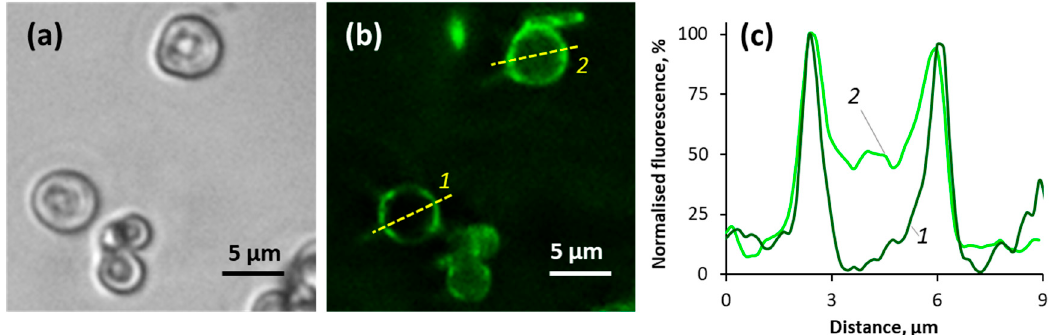
Figure 7. Transmittance ( a ) and fluorescence ( b ) microscopy images of vaterite crystals (4 mg mL − 1 CaCO 3 ) after incubation with mucin-FITC (1 mg mL − 1 ) for 15 min; and ( c )-fluorescence profiles taken along the yellow lines 1 and 2 across the particles in the image ( b ).